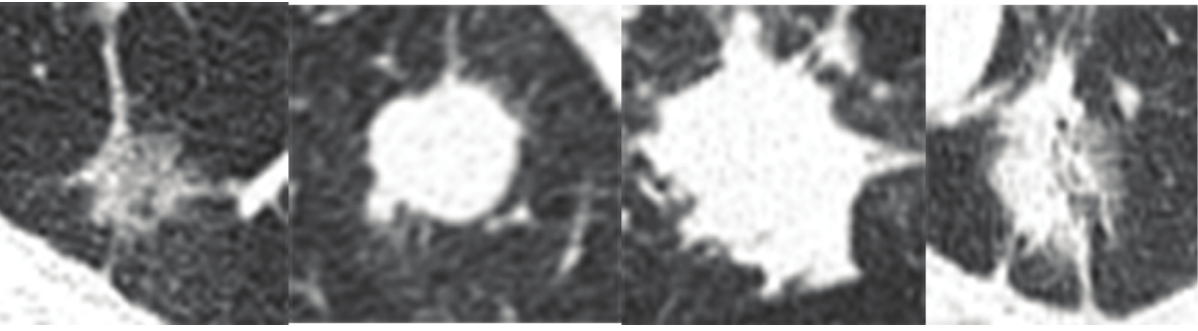
Figure 2: ROI areas of four types tumors, from left to right are ISA (adenocarcinoma in situ), SCLC (small cell lung cancer), SCC (squamous cell cancer) and IA (invasive adenocarcinoma).